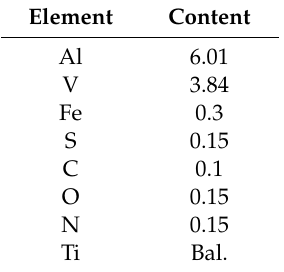
Table 1. Chemical composition (wt.%) of Ti6Al4V alloy. Element Content